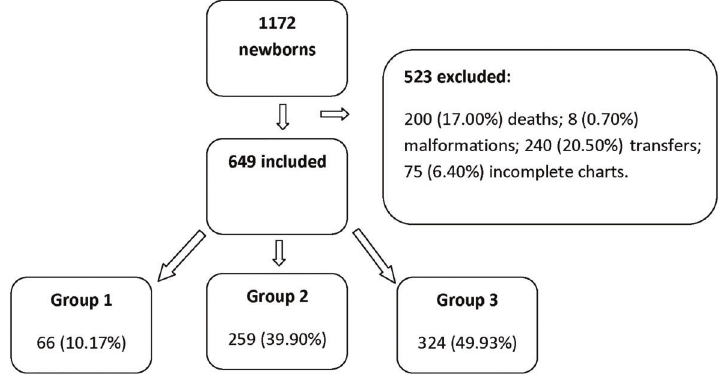
Figure 1. Flowchart of participant selection accord- ing to type of feeding at discharge: exclusive